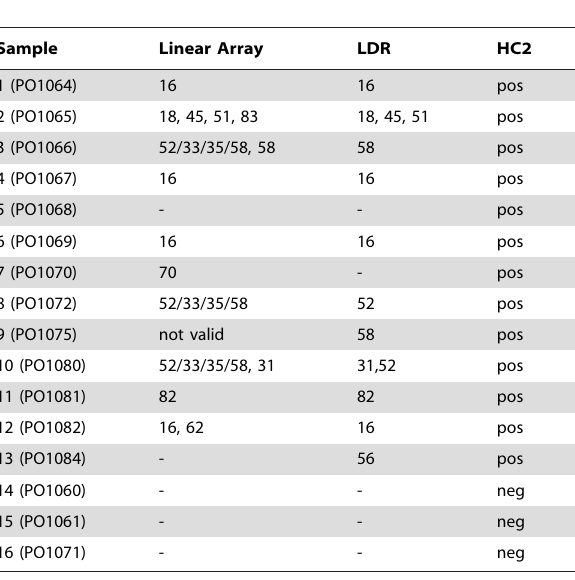
Table 2. Analysis of patient samples with Roche Linear Array, LDR and Qiagen Hybrid Capture 2.